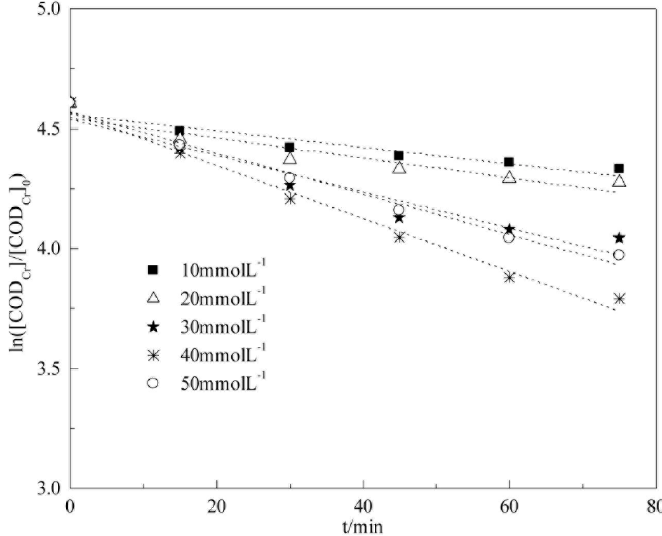
Figure 14. Effect of apparent rate constant on different H 2 O 2 concentrations. Table 6. Apparent reaction rate constant of different H 2 O 2 concentrations.